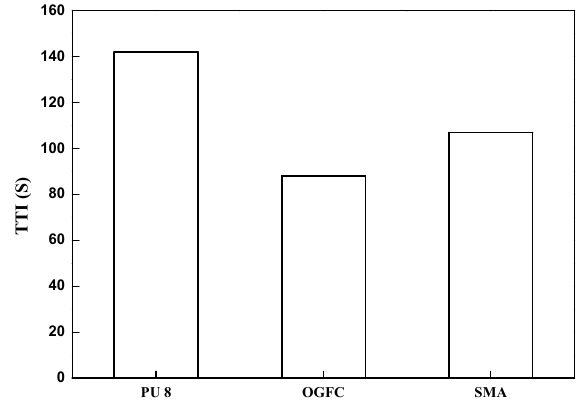
Figure 10. Comparison of ignition time (TTI) among PU, OGFC and SMA.